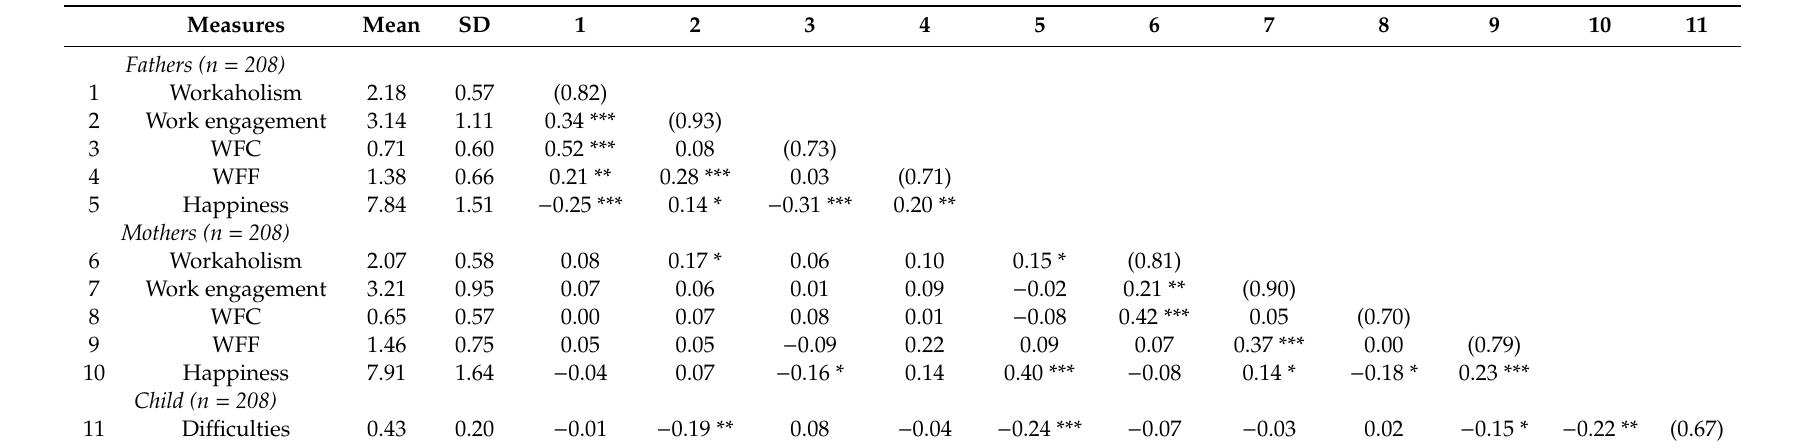
Table 2. Means, SDs, Cronbach’s Alphas, and correlations of the variables used in the study ( N = 208